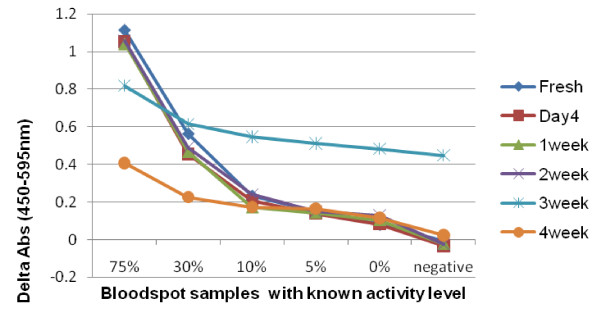
Assay performance with assay mix stored for up to 4 weeks. Absorbance readings from bloodspot samples with known levels of G6PD using assay mixes stored for varying durations at ambient temperature. Each line represents assay results with a different assay mix. Uniform assay performance was observed with assay mixes stored for up to 2 weeks, but abnormal or degrading performance was observed in those stored for 3 and 4 weeks.